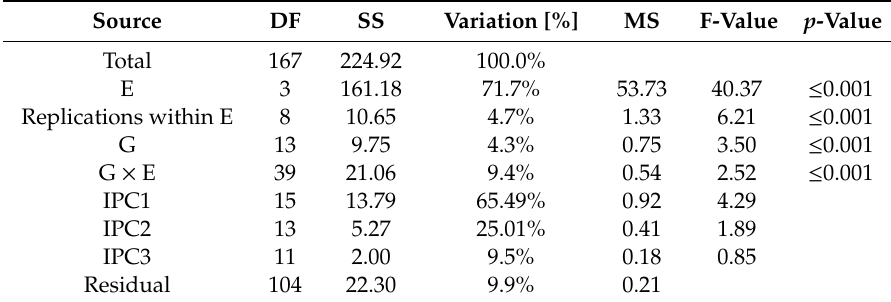
Table 5. Additive main e ff ect and multiplicative interaction (AMMI) analysis of variance for main e ff ect “environment (combination of growing seasons and management systems—E)” and “genotype—G”, and their interaction on grain